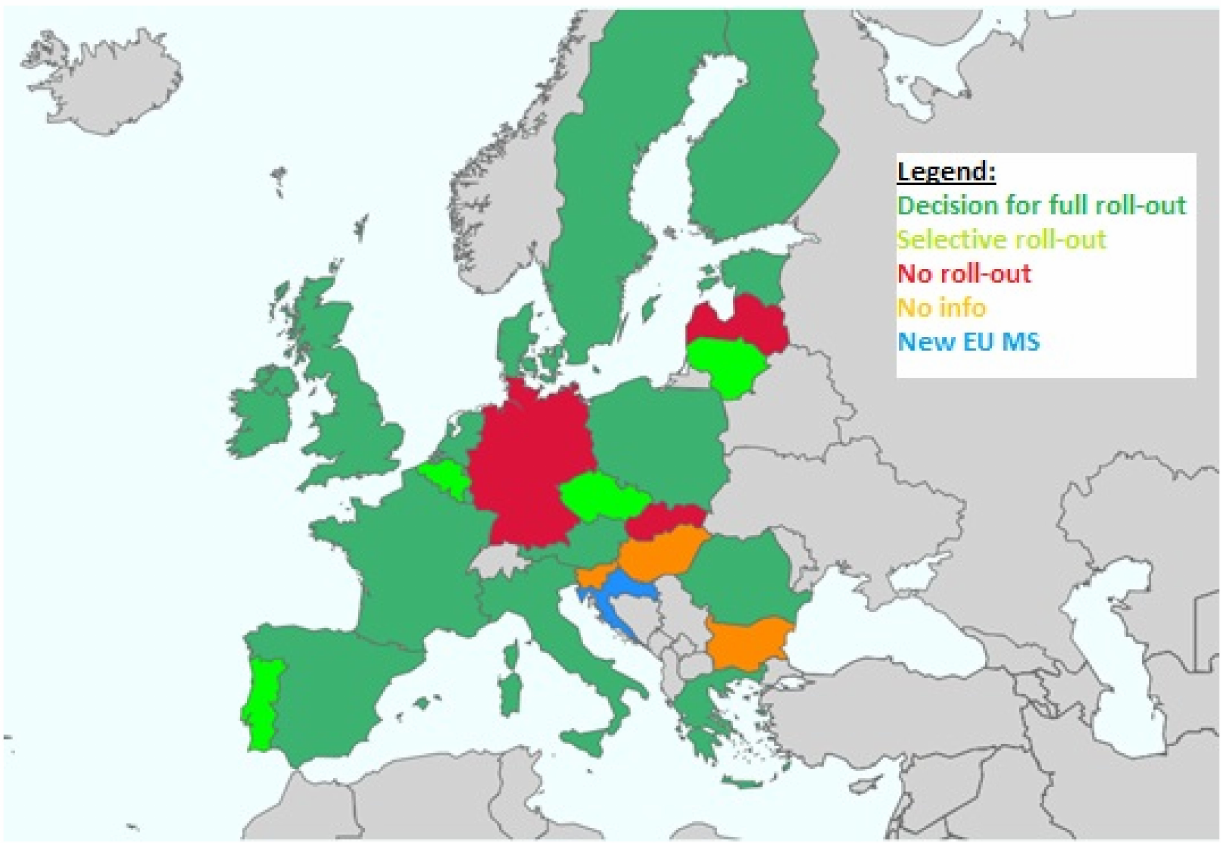
Figure 1. Results of national cost–benefit analyses for smart metering roll-out in 2014, Source: